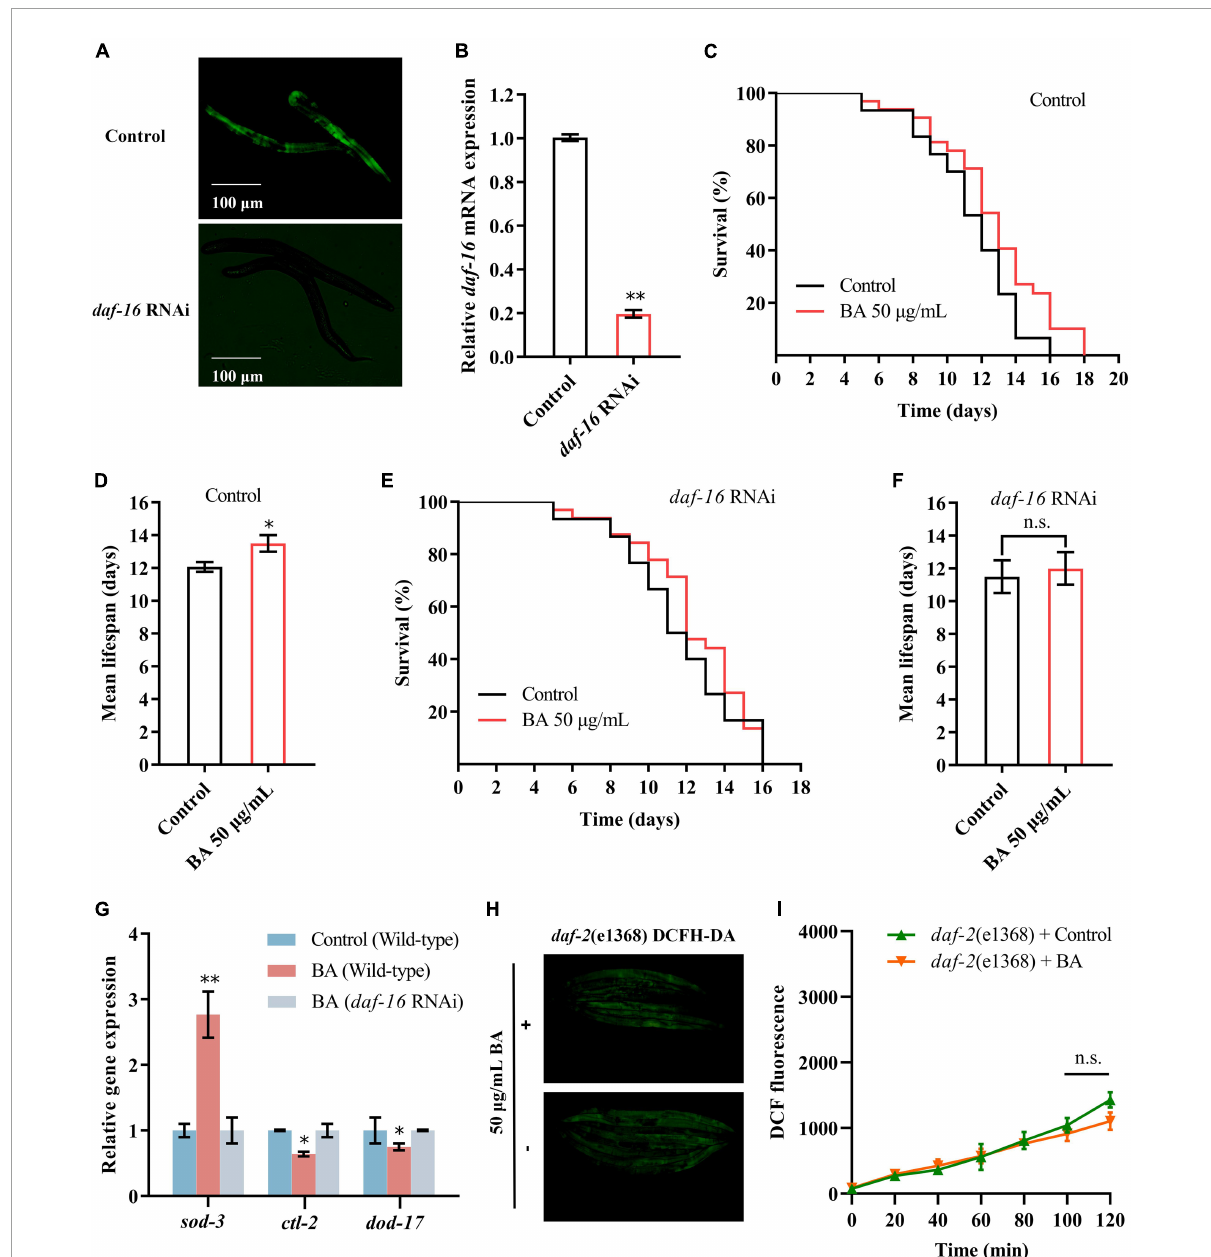
FIGURE6 Insulin/IGF-1 receptor signaling mediates betulinic acid (BA)-induced longevity and stress resistance. (A) Evaluation of daf-16 RNAi efficiency using the transgenic Caenorhabditis elegans expressing DAF-16:GFP. (B) RT-qPCR quantification of daf-16 mRNA levels after RNAi. (C,D) Kaplan-Meier survival curve and mean lifespan of BA-induced longevity in wild-type animals. (E,F) Kaplan-Meier survival curve and mean lifespan of BA-induced longevity in daf-16 RNAi animals. (G) Effects of BA on the expression of daf-16 downstream genes ( sod-3 , ctl-2 , and dod-17 ). (H,I) Effects of BA on ROS level in wild-type animals and daf-2 mutants. Representative images of DCFH-DA staining (H) and quantification of fluorescence intensity (I) were presented. Data were displayed as the mean ± SEM. For panels (G,I) , comparisons represent the One-way ANOVA followed by post-hoc Bonferroni’s test. For panels (B,D,F) , comparisons represent two-tailed unpaired Student’s t -test. ∗ P < 0.05; ∗∗ P < 0.01; ns =